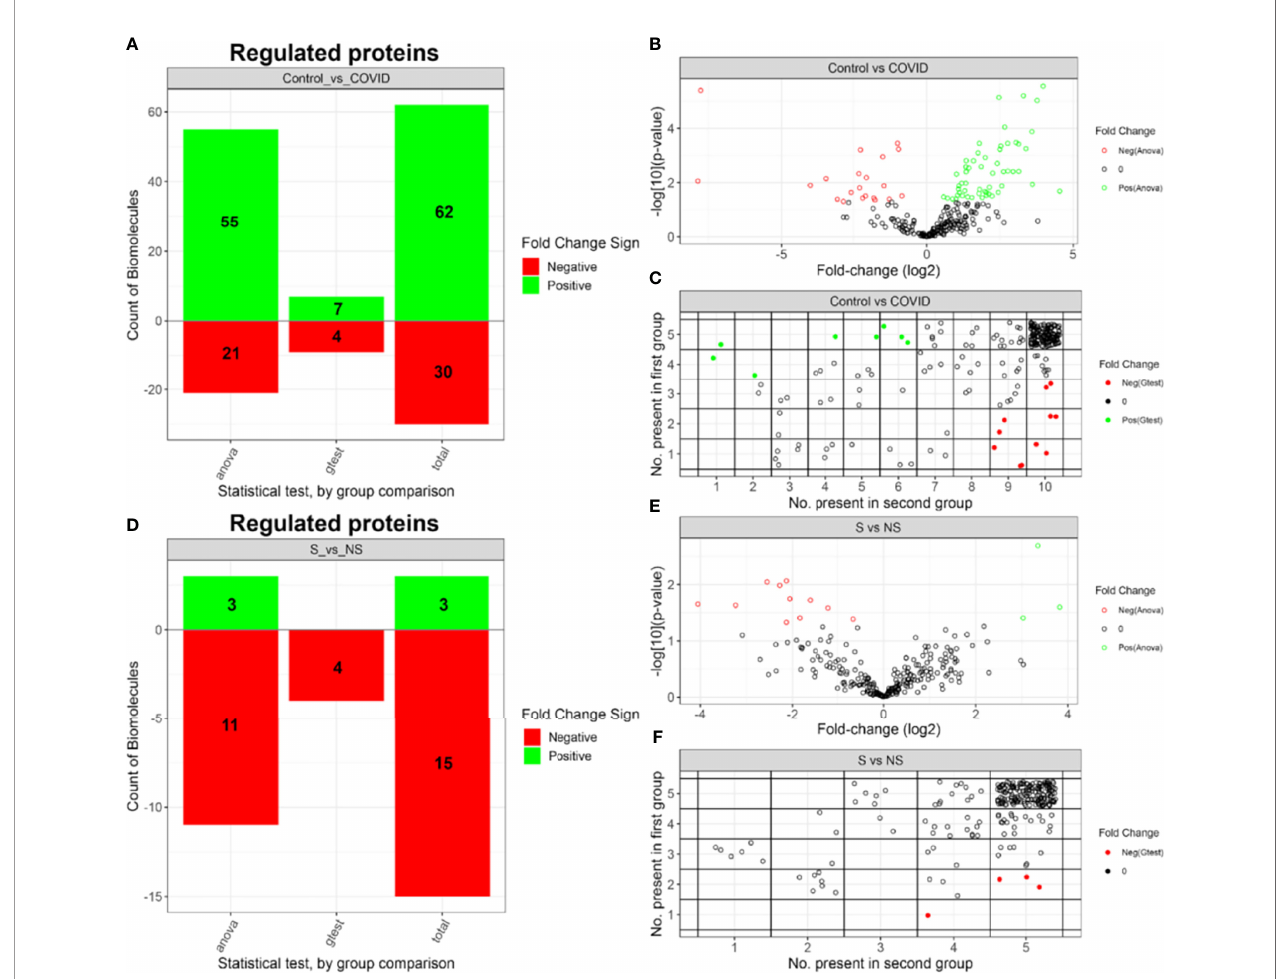
FIGURE 7 | Summary of IMD-ANOVA regulated proteins. (A) Number and FC signal of regulated proteins identi fi ed by each approach in C vs COVID-19 comparison. (B) Volcano plot of C vs COVID-19 comparison. (C) Number of proteins observed in each control and COVID-19 groups. (D) Number and FC signal of regulated proteins identi fi ed by each approach in S vs NS groups. (E) Volcano plot of S vs NS comparison. (F) Number of proteins observed in each S vs NS groups. Control group (C), COVID-19 survivors (S), and COVID-19 non-survivors